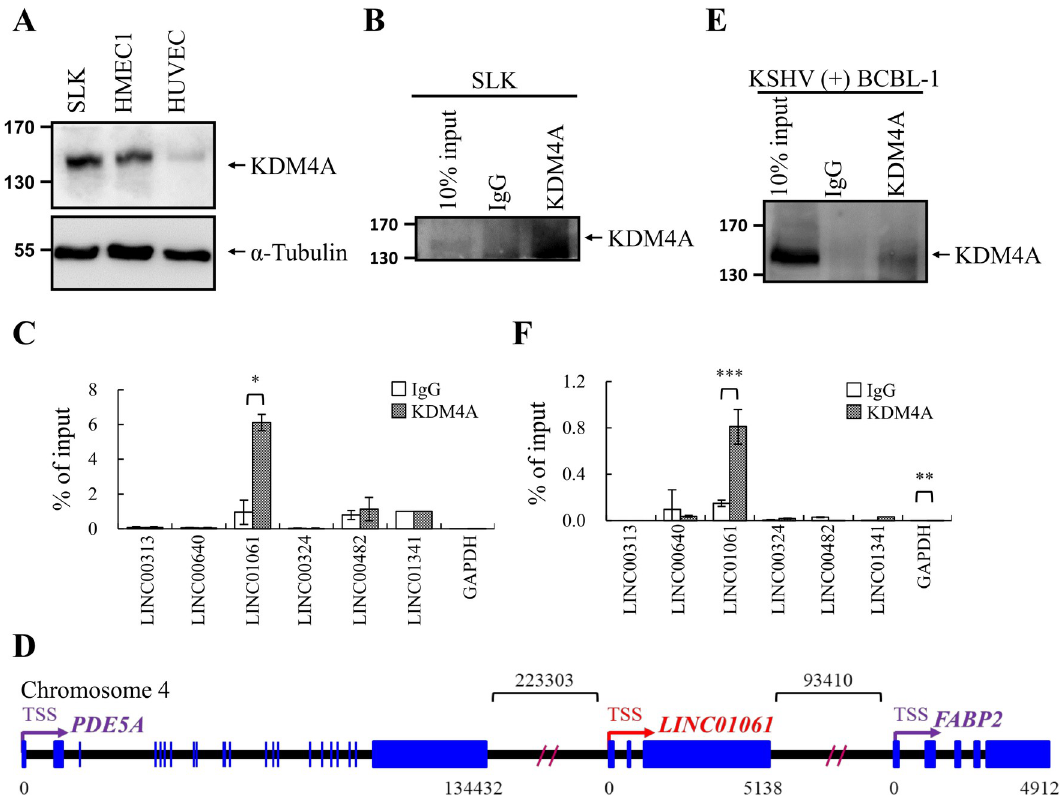
Fig 2. KSHV-Induced KDM4A-Associated Transcript (KIKAT)/LINC01061 is associated with histone lysine demethylase 4A (KDM4A). (A) Total cell lysates (TCLs) prepared from SLK, HMEC1 and HUVEC were examined for KDM4A by immunoblotting. Anti- α -Tubulin antibody was included as loading control. (B) SLK cell lysate was used for RNA immunoprecipitation (RIP) using KDM4A antibody or rabbit IgG as control. Immunoprecipitation (IP) specificity was confirmed by immunoblotting. (C) Copurified RNA from KDM4A and IgG IPs in (B) was assessed for LncRNAs enrichment by RT-qPCR. (D) Schematic diagram represented the structure of KIKAT/LINC01061 and the nearby genes Phosphodiesterase 5A (PDE5A) and Fatty acid-binding protein 2 (FABP2). Exons and introns are showed as blue boxes and thin lines, respectively. Arrows labeled transcription start site (TSS) and transcription direction. The numbers below the boxes and above the lines indicate the length of transcripts and of intergenic regions, respectively. (E) Cell lysate from TREx-F3H3-K-Rta BCBL-1 cells was used for RIP using KDM4A antibody or rabbit IgG as control. IP specificity was confirmed by immunoblotting. (F) Copurified RNA from KDM4A and IgG IPs in (E) was assessed for LncRNAs enrichment by RT-qPCR. Significance was determined by student’s t -test. � p < 0.05, �� p < 0.01, ��� p < 0.001.